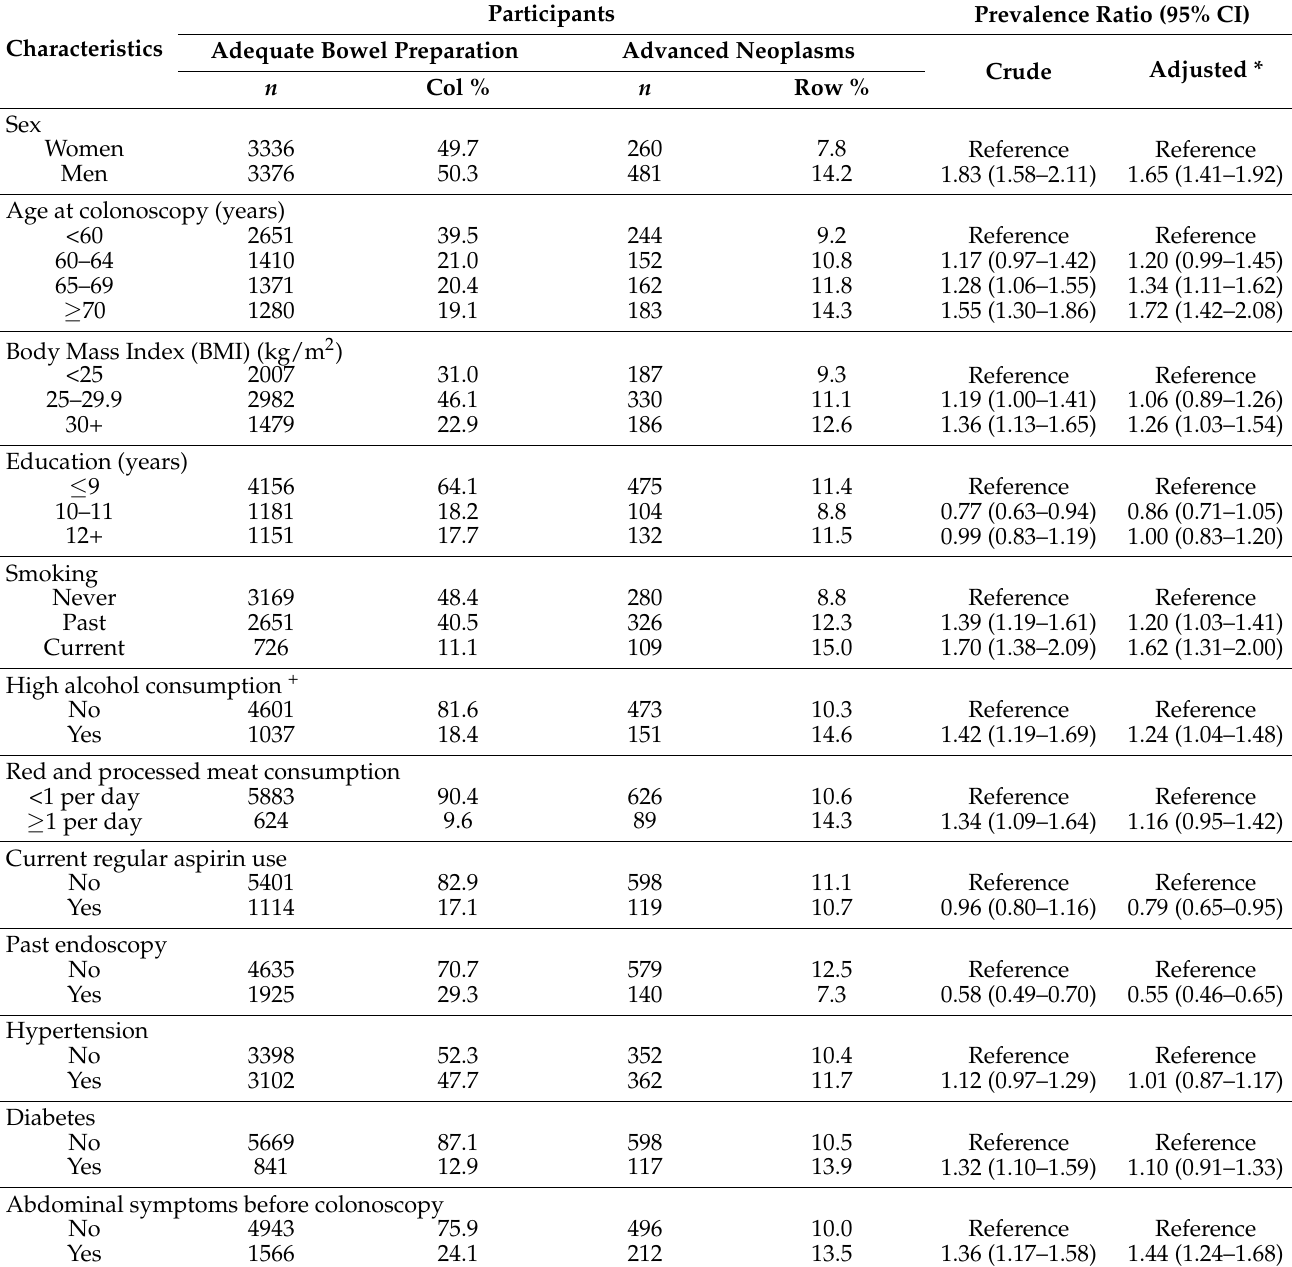
Table 2. Characteristics of the study population and association with prevalence of advanced neoplasms among participants with adequate bowel